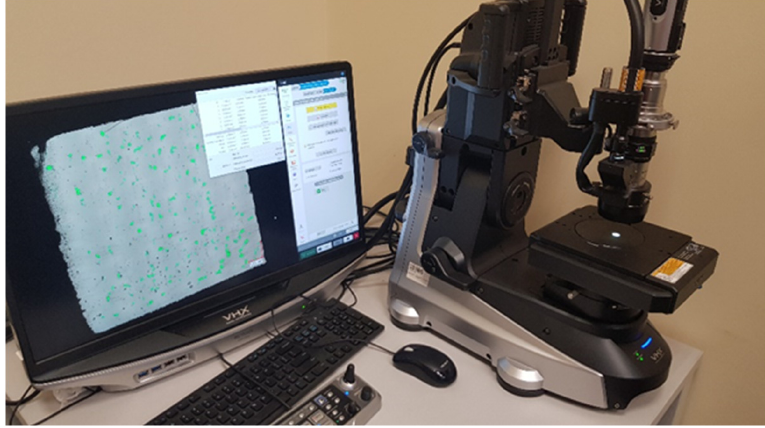
Figure 5. Keyence VHX-7000 digital microscope.